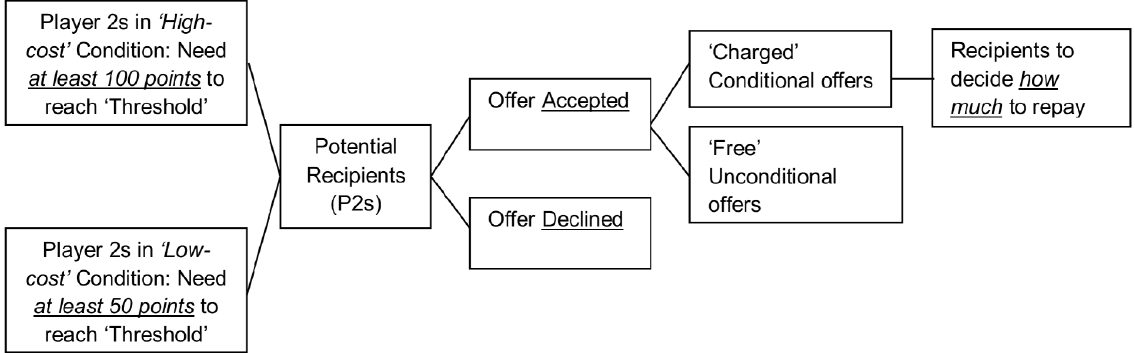
Fig. 2. The flow of decisions made by a potential recipient (Player